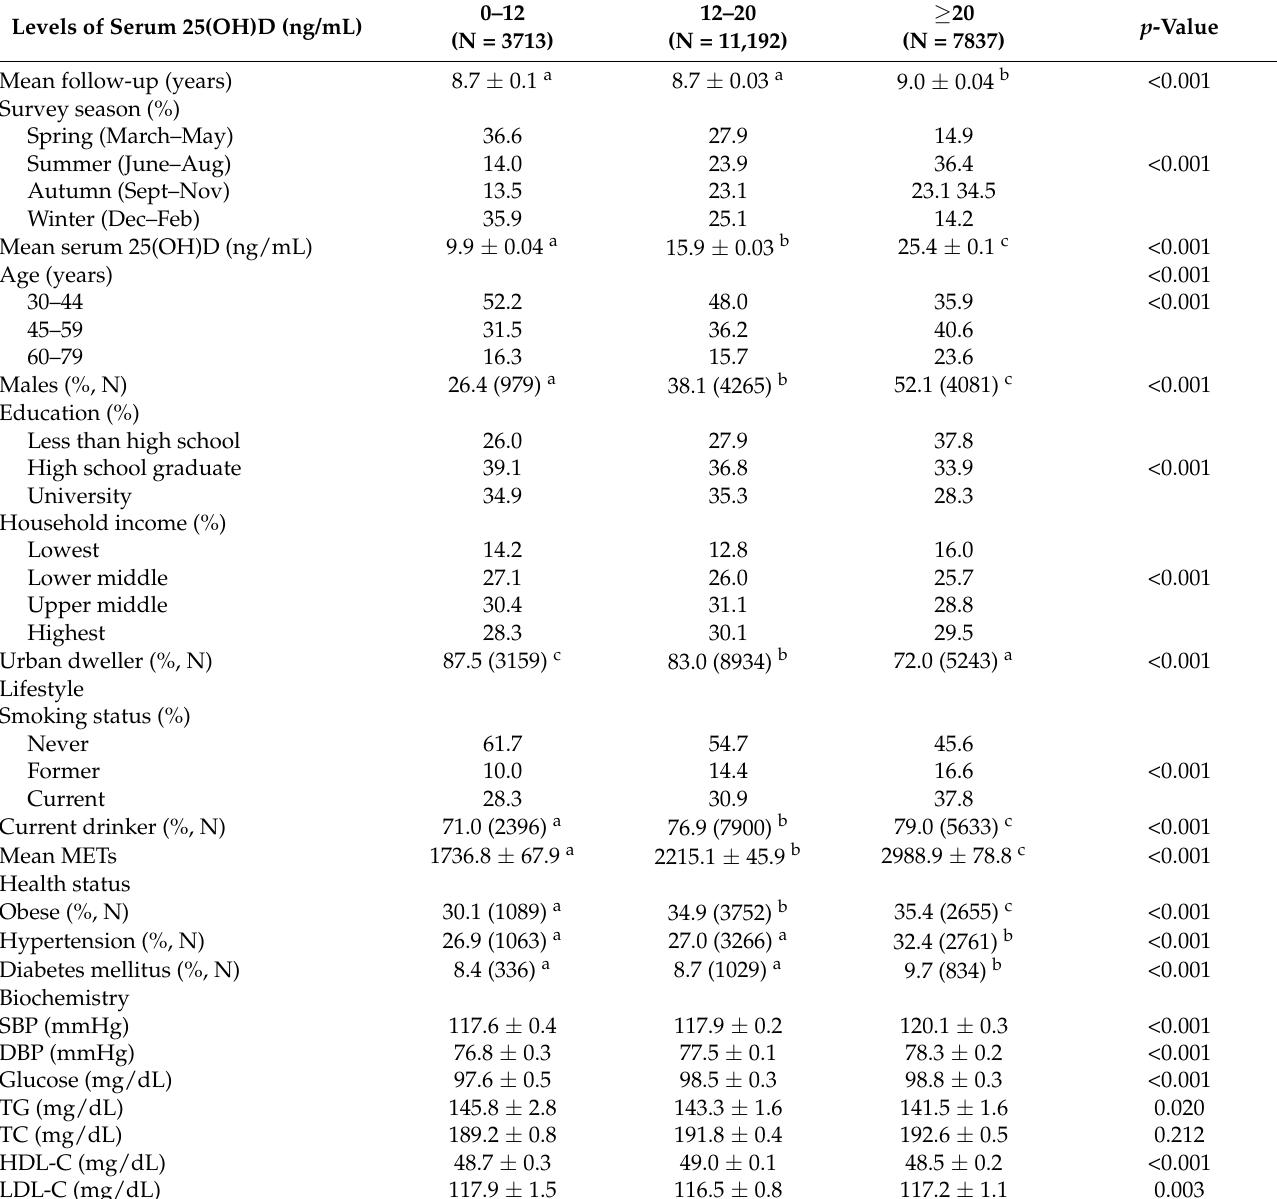
Table 1. Baseline characteristics of study population by level of serum